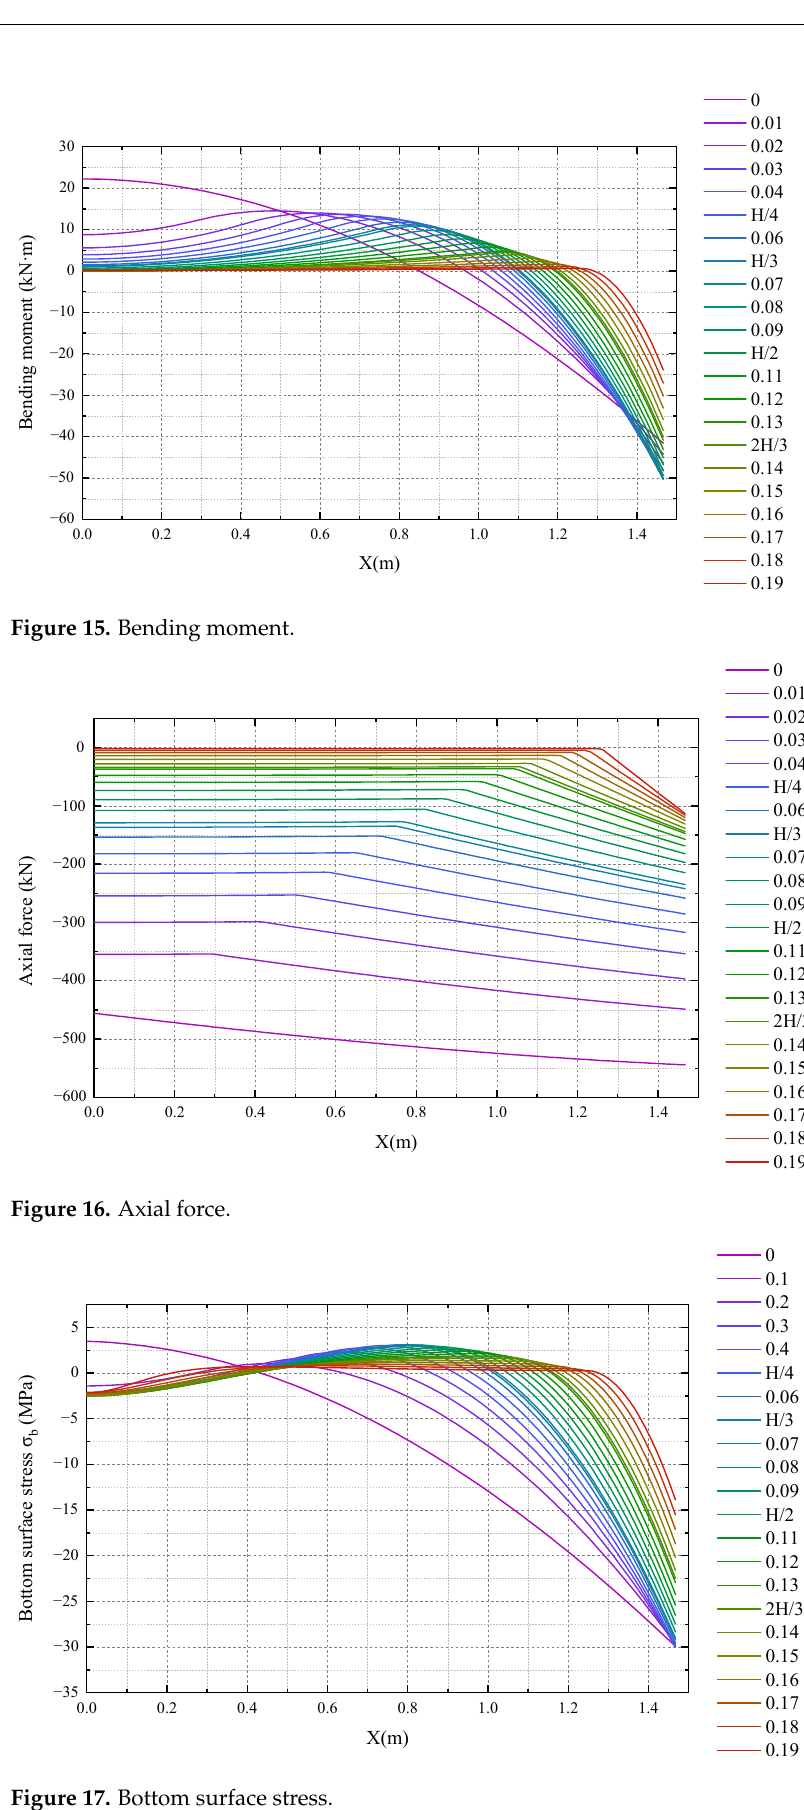
Figure 17. Bottom surface stress.